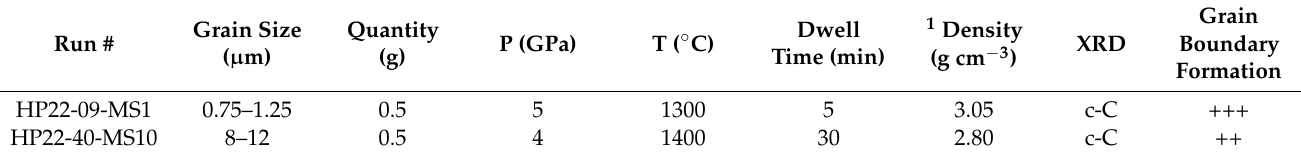
Table 1. Experimental conditions and main results.